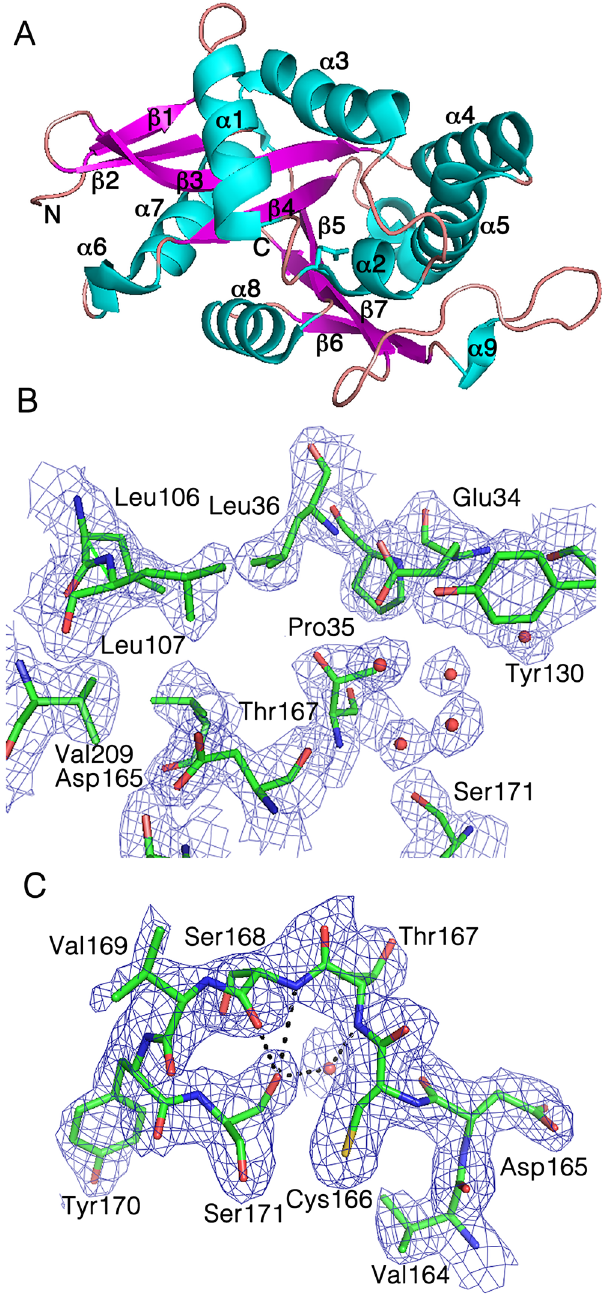
Figure 1. Crystal structure for AgmNAT at 2.3 Å. ( A ) Overall structure with labeled secondary structures. The two termini are labeled as N and C. ( B ) 2Fo-Fc electron density map of AgmNAT active site, contoured at 1.0 σ . Ordered water molecules are indicated by red spheres. ( C ) 2Fo-Fc electron density map (1.0 σ ) of the Ser-171 region interacting with the 165–169 strand